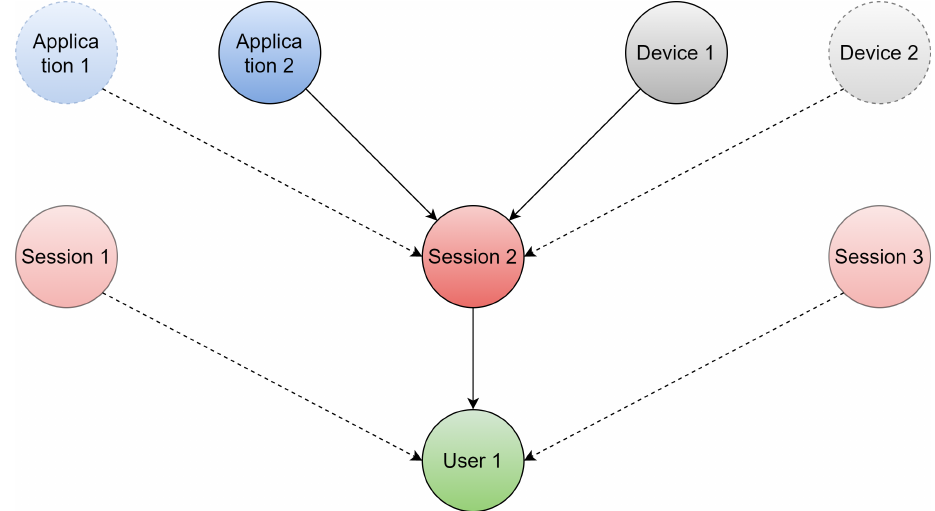
Figure 1. Generalized graphical diagram of the model.